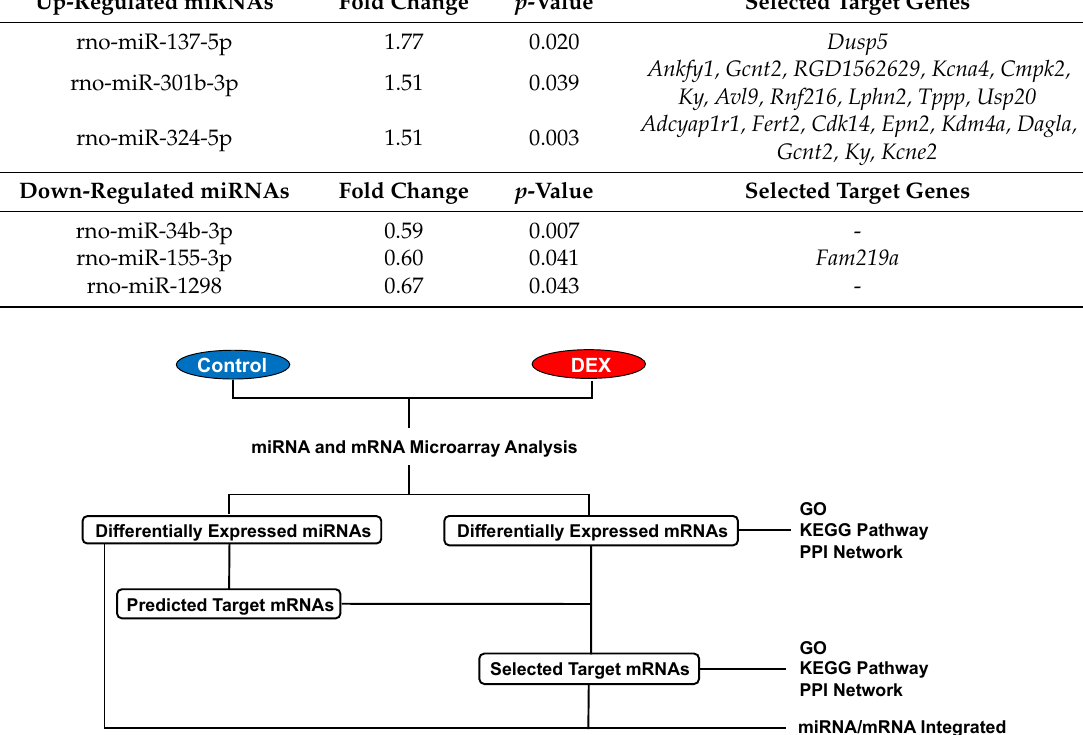
Table 1. Differentially expressed miRNAs and the selected target genes.